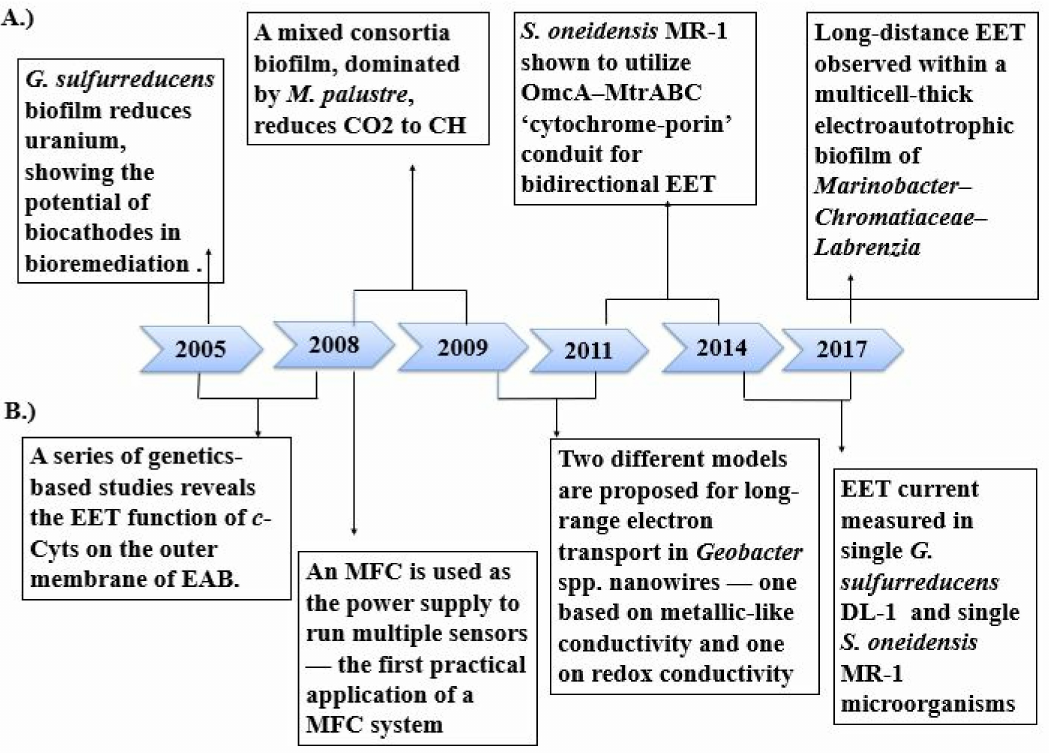
Figure 1. Timeline showing development in microbial electrosynthesis and electron transfer systems. ( A ) Chronological development of biocathode applied technologies and ( B ) advancements in anodic microbial electrocatalysis and extracellular electron transfer in microbial electrochemical cell